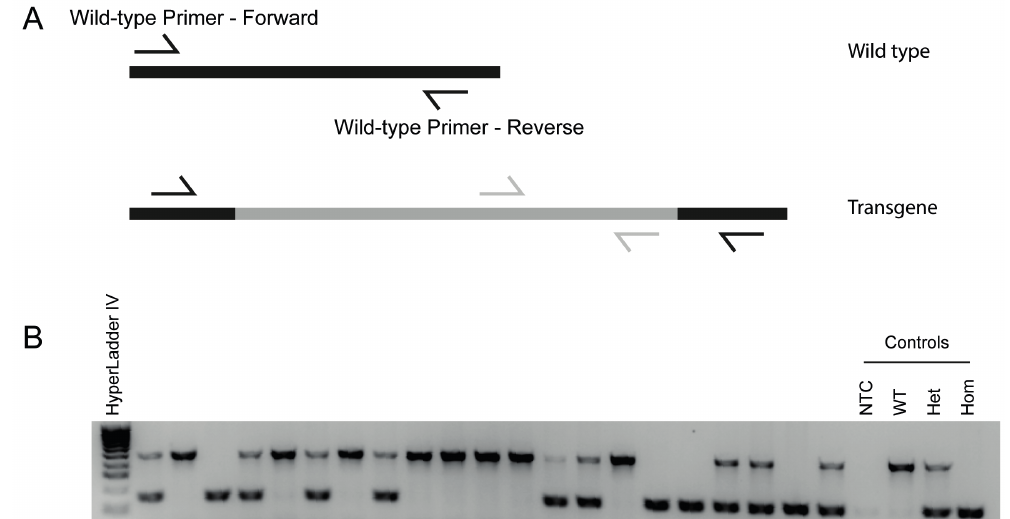
Figure 2. Genotyping strategy for homozygous mice. ( A ) Primer design to produce a wild-type product that is disrupted in the presence of the transgenic allele. ( B ) Samples visualised on a 2% agarose gel showing wild-type (top band), homozygous (bottom band) and hemizygous (both bands) animals.